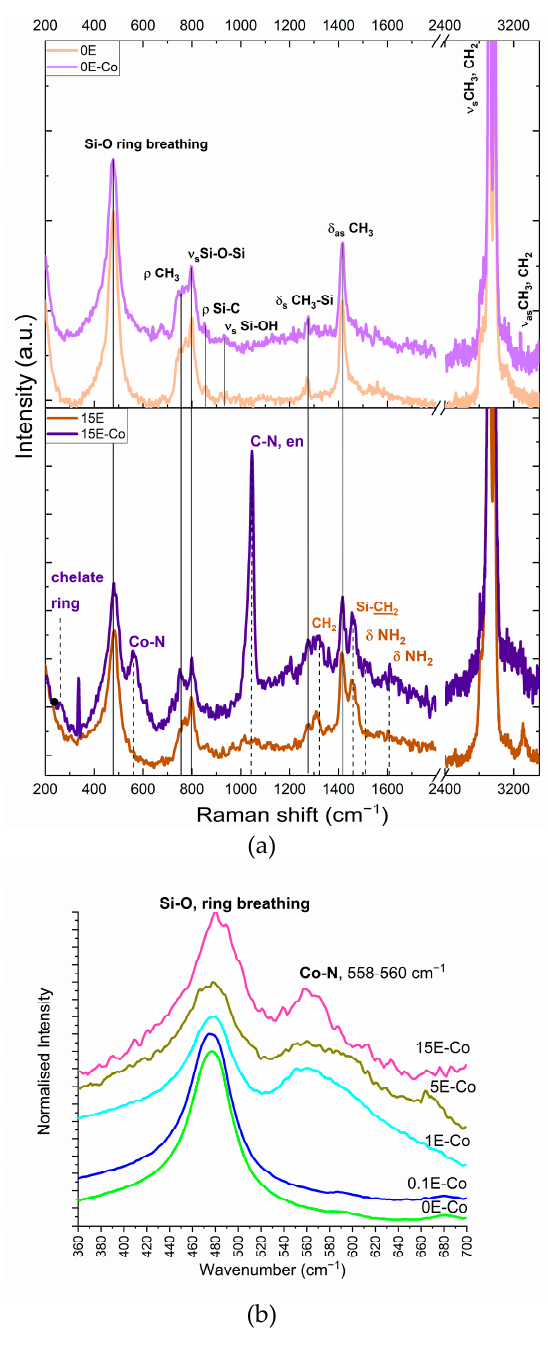
Figure 6. ( a ) Raman spectra of the aerogels; ( b ) Co–N bond vibration bands in the Raman spectra of the aerogels.